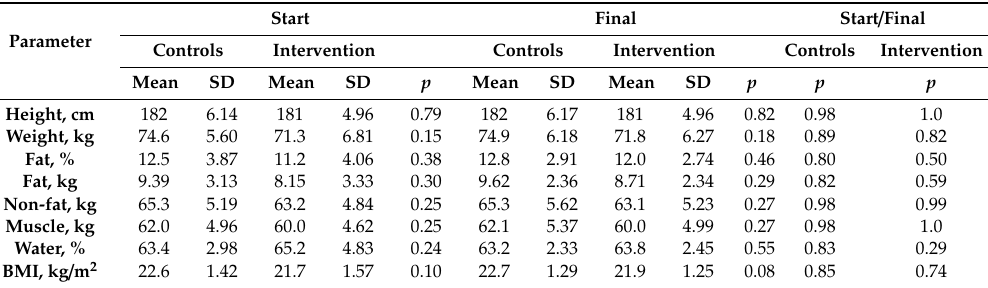
Table 3. Anthropometric and body composition